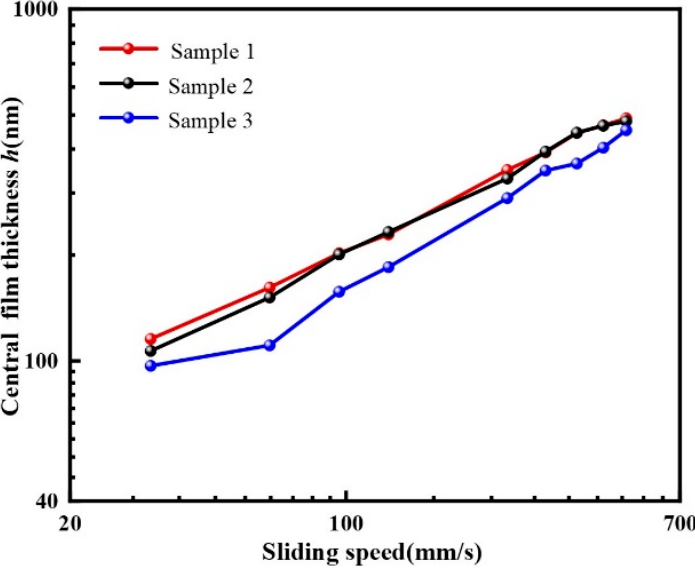
Figure 11. Central film thickness of sample 1 and sample 2 with textures located in the contact area.